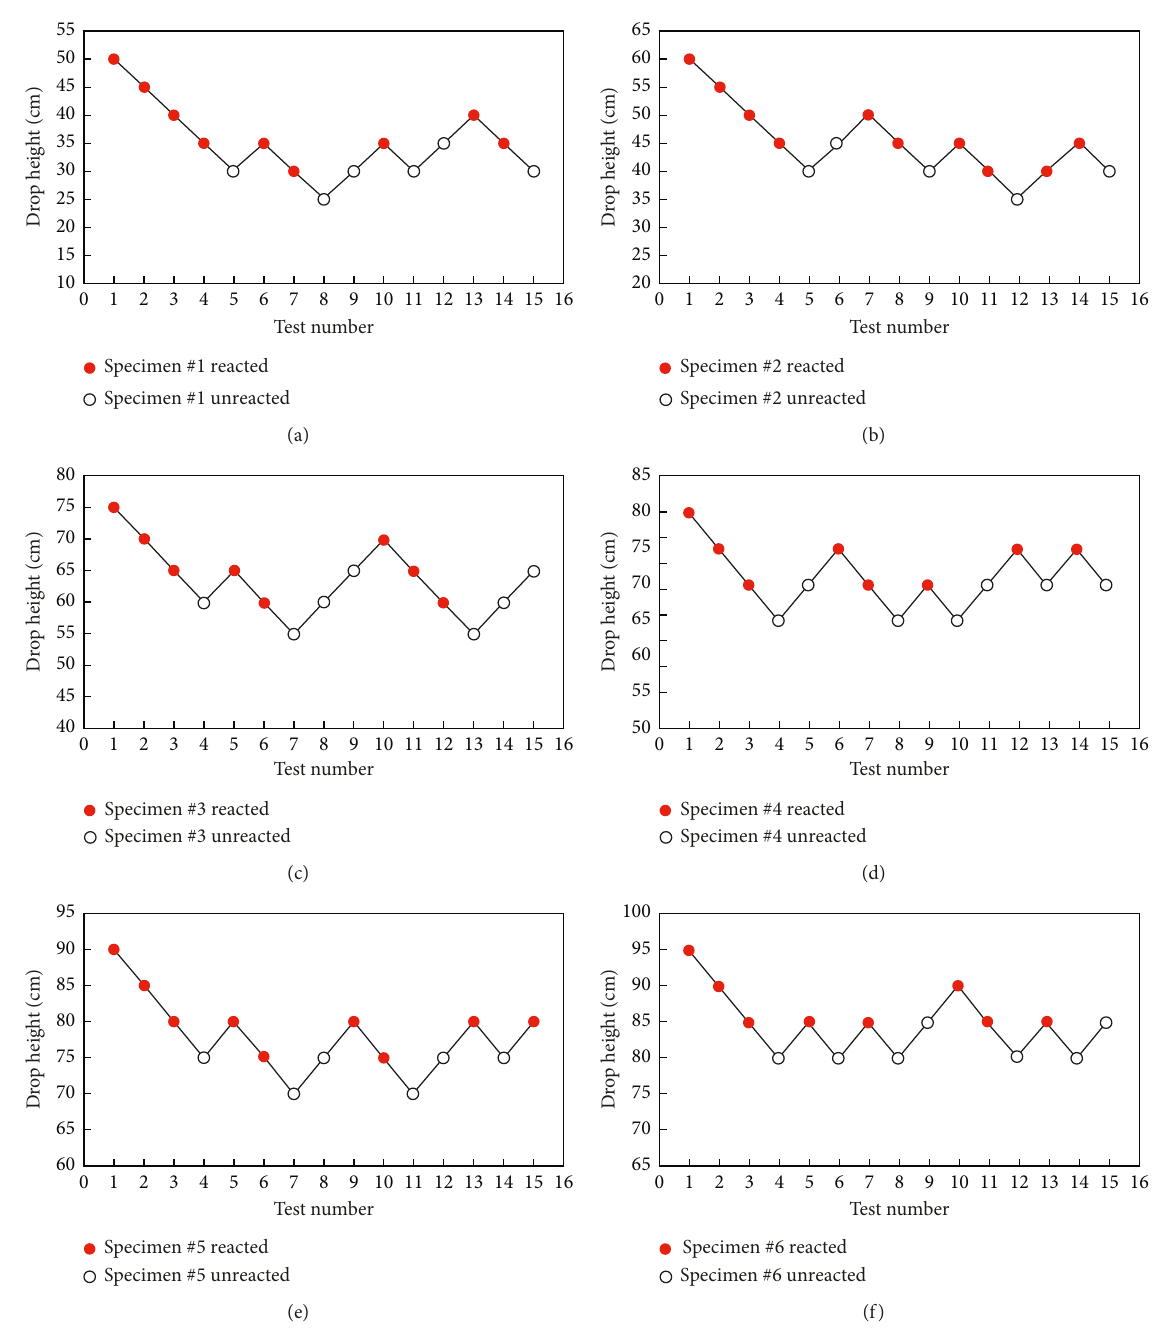
Figure 7: The drop weight test data points for specimens #1–#6. Table 3: The characteristic drop height and ignition energy for specimens